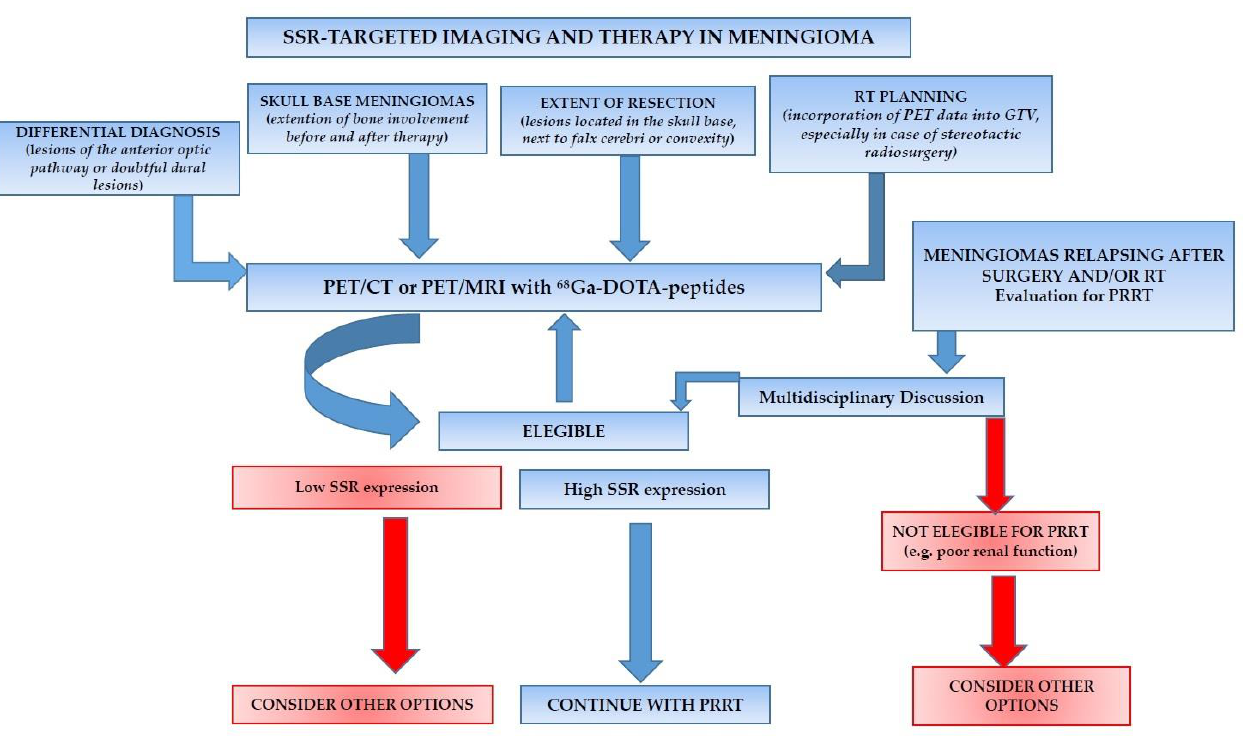
Figure 5. Schematic representation of the possible collocation of SSR-targeted imaging and therapy in meningiomas’ clinical work-flow, highlighting the central role of PET-imaging with 68 Ga-DOTA- peptides.